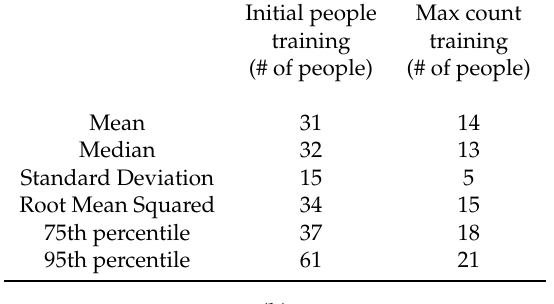
Figure 20. A cumulative distribution function plot comparing the obtained crowd estimation error values for the Nucleus tent data for two different training approaches. ( a ) shows the actual plot while the table shown in ( b ) contains several key statistical